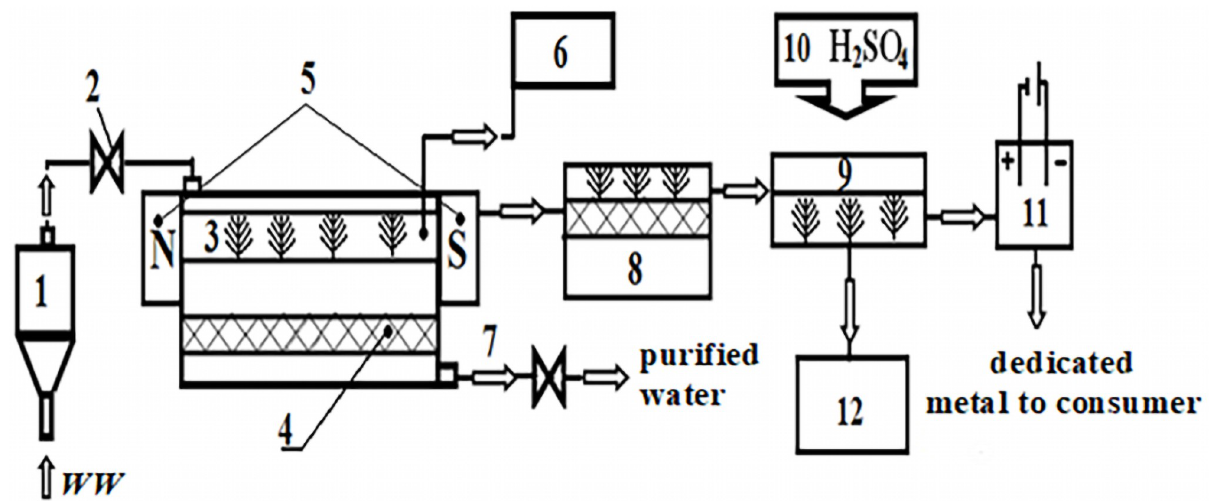
Fig 9. Schematic diagram of the phytoremediation of metals from WW. 1 –a WW averager; 2 –a pump for pumping averaged water into a biopond; 3 –a biopond populated by higher aquatic vegetation; 4 –a mesh pan for collecting and holding Lemna minor duckweed during the discharge of purified water; 5 –an installation of a constant magnetic field (can be combined with weak electric fields.); 6 –an equipment for monitoring the residual content of copper cations in solution; 7 –a pump for pumping purified water; 8 –lifting the waste mass by a pallet; 9 –bath for the preparation of the eluate; 10 –a dispenser of sulfuric acid; 11 –a metal electrolysis bath; 12 –a capacity for the collection of neutralized phytomass and its disposal.